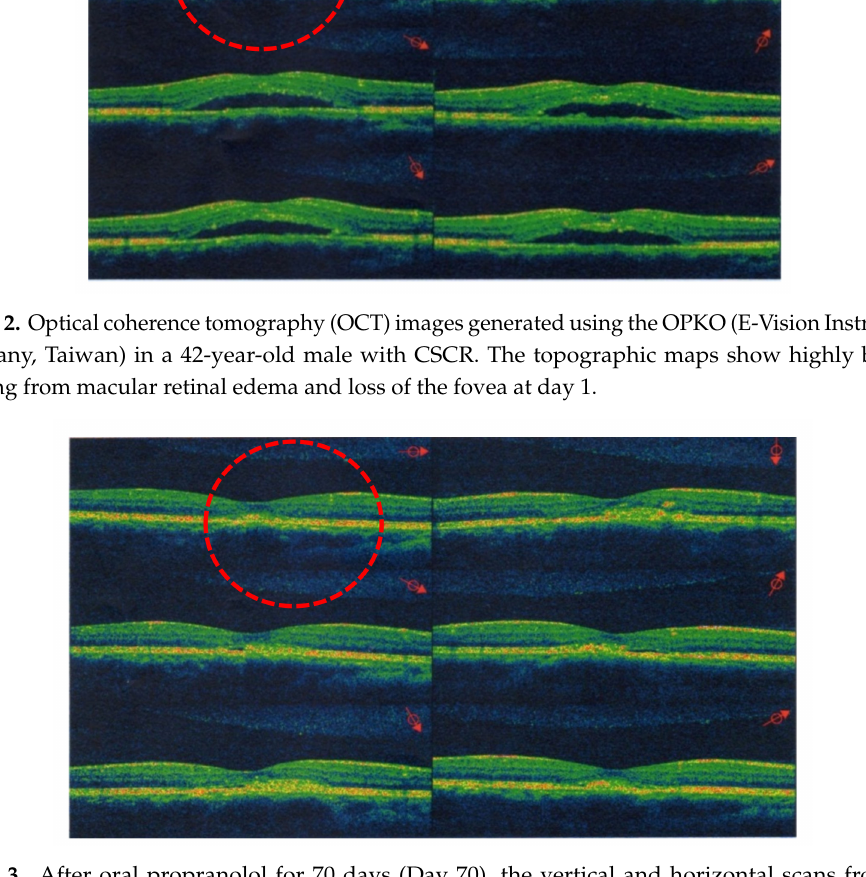
Figure 3. After oral propranolol for 70 days (Day 70), the vertical and horizontal scans from the 42-year-old male with CSCR show that the retinal pigment epithelium (RPE) had detached with significantly reduced macular edema. Therefore, the patient was considered as a “success” case for propranolol treatment in group